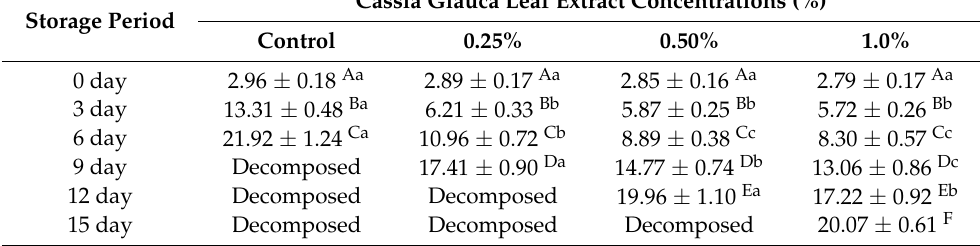
Means carrying a different capital or small superscript are significantly different ( p < 0.05) in the same column and row, respectively. Table 4. The pattern of thiobarbituric acid (TBA) (mg/kg) of minced beef treated with ethanolic Cassia glauca leaf extracts (0.25%, 0.5%, 1%) during the cold storage period at 3 ± 1 ◦ C (mean ± standard deviation “SD”).